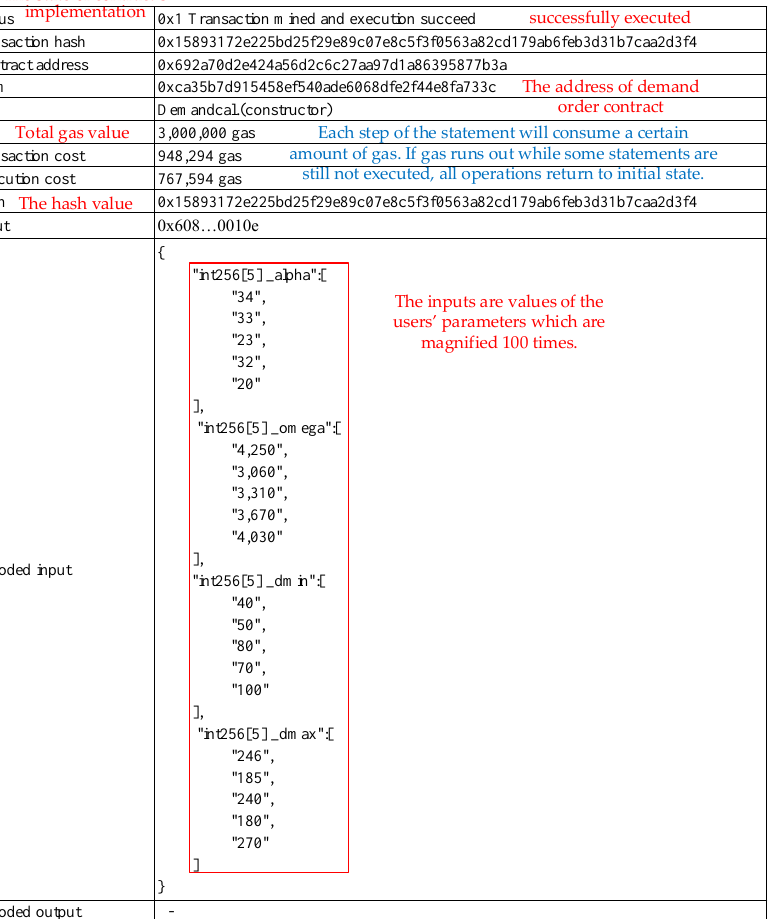
Figure 3. Input of the buyers’ characteristic parameters.